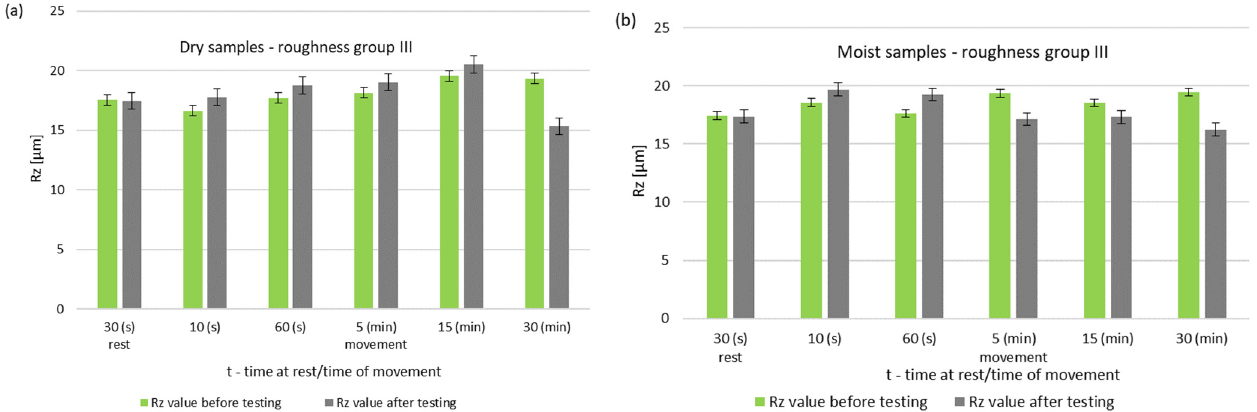
Figure 11. Changes in the value of the parameter Rz of steel pins for roughness group III (Rz = 17.54–19.55 µ m): ( a ) tests performed in dry conditions, ( b ) tests performed with moist graphite rings.